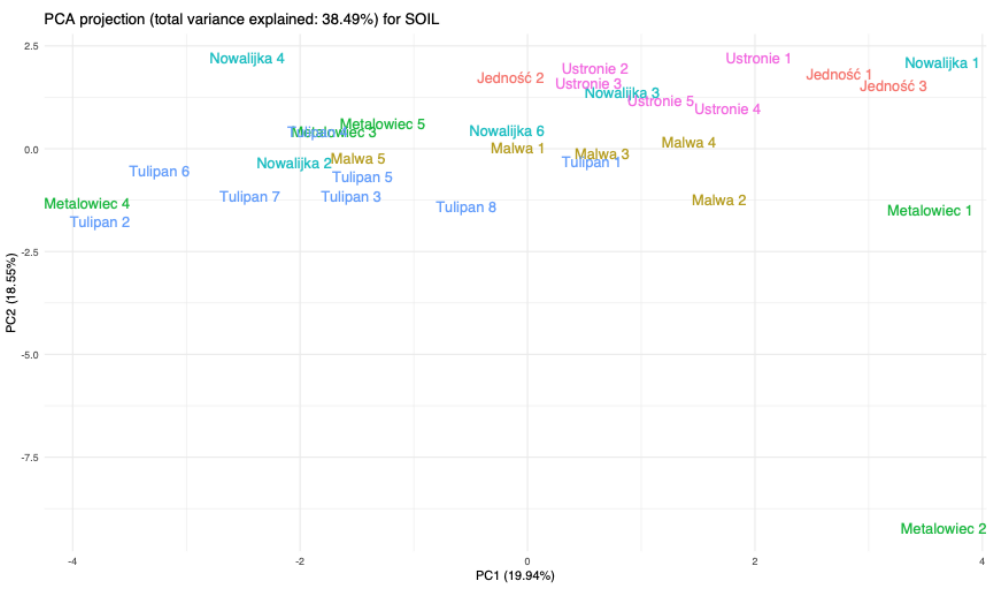
Figure 2. PCA relationship among studied allotment plots in respect to soil parameters.